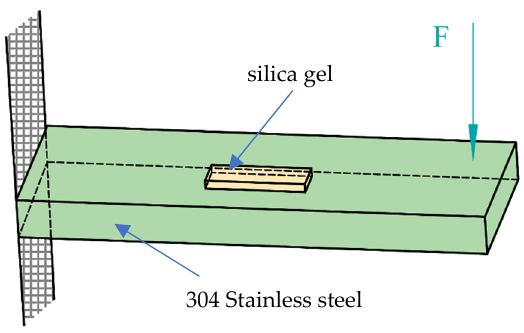
Figure 2. Sensor simulation model.